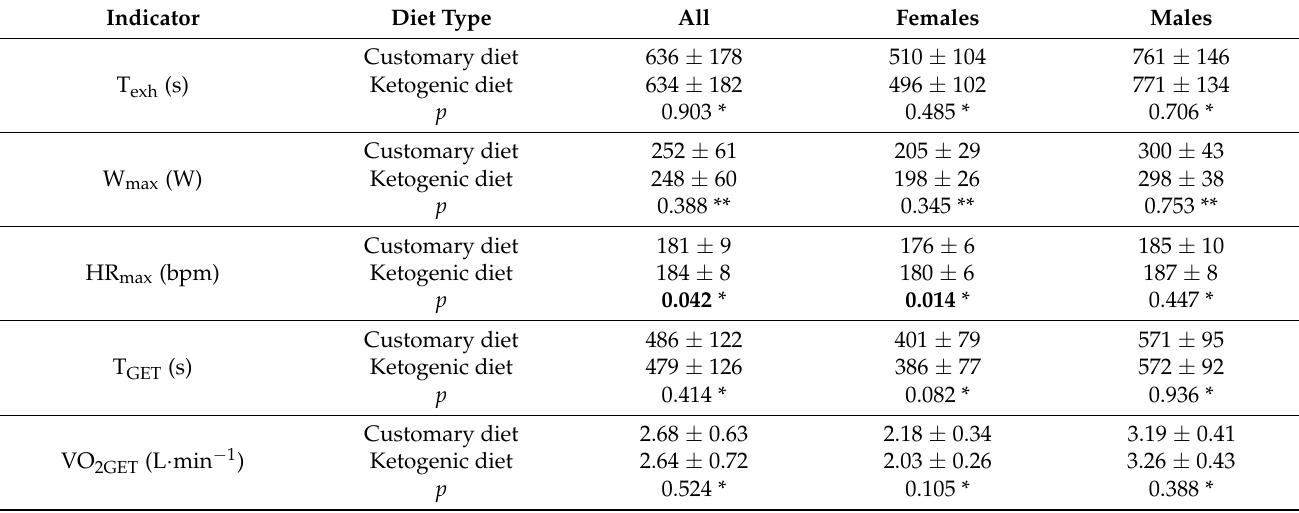
Figure 2. Peak oxygen uptake (VO 2peak , L·min − 1 ) in the incremental cycling test (ICT). Values are expressed as the mean (black fill) ± standard deviation and as raw data (white fill). All: ♦ , females: O, males: ∆ . Data were analysed by repeated-measures one-way analysis of variance. Statistical significance was set at p < 0.05. Table 2. Incremental cycling test (ICT) results.